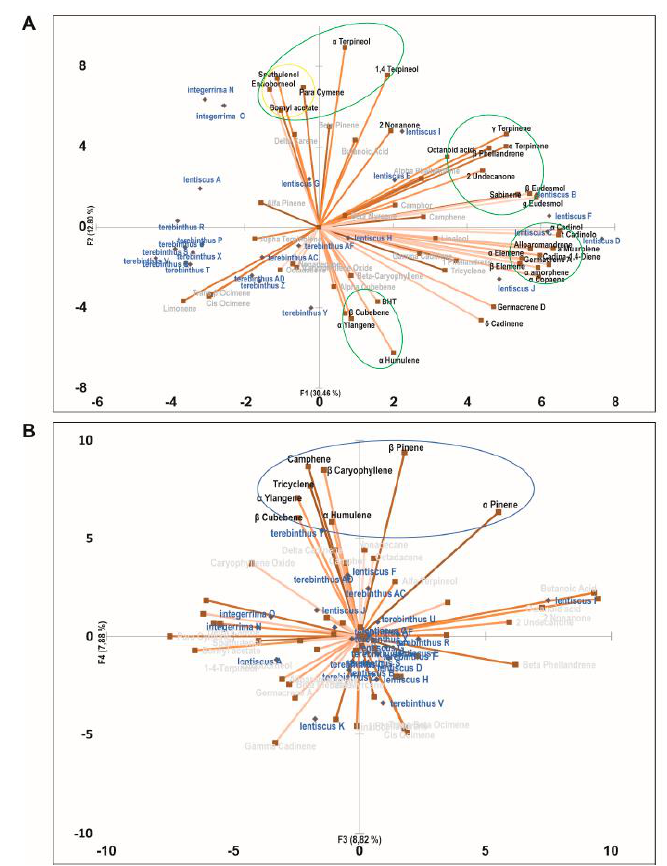
Figure 2. Principal Component Analysis of the cytotoxic effect of Pistacia essential oils on LoVo cells. ( A ) principal component analysis (PCA) biplot with PC1 and PC2 distribution of essential oil samples and chemical components of the phytocomplexes. ( B ) PCA biplot with PC3 and PC4 distribution of essential oil samples and chemical components of the phytocomplexes. Clusters of cooperating compounds with a positive correlation to one or two components are identified with circles (green for P. lentiscus , yellow for P. integerrima , and blue for P. terebinthus ). Taken with permission from Buriani et al. [68].